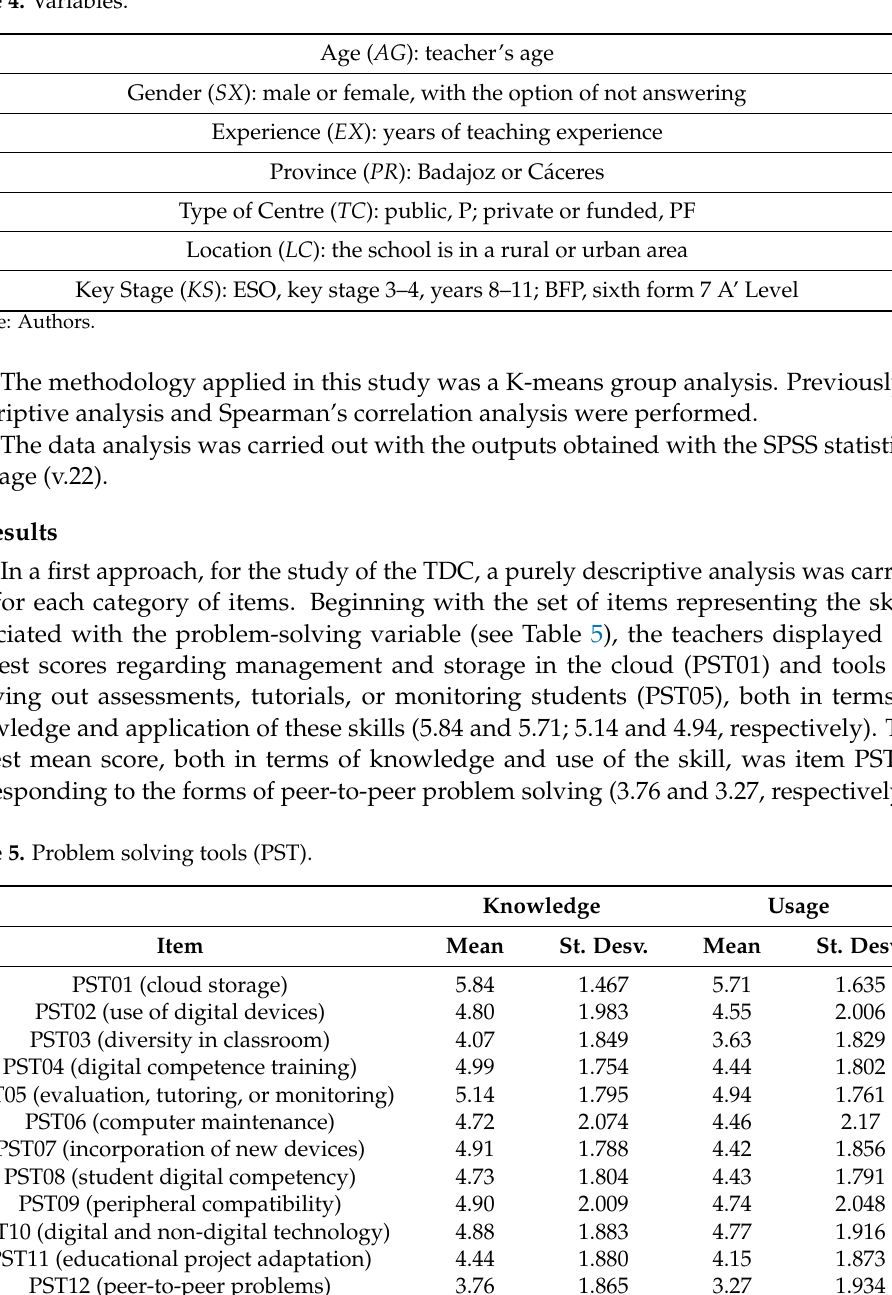
Table 4. Variables.